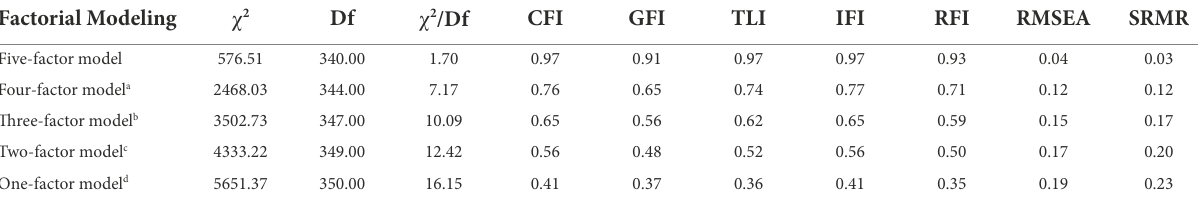
TABLE 2 Confirmatory factor analysis